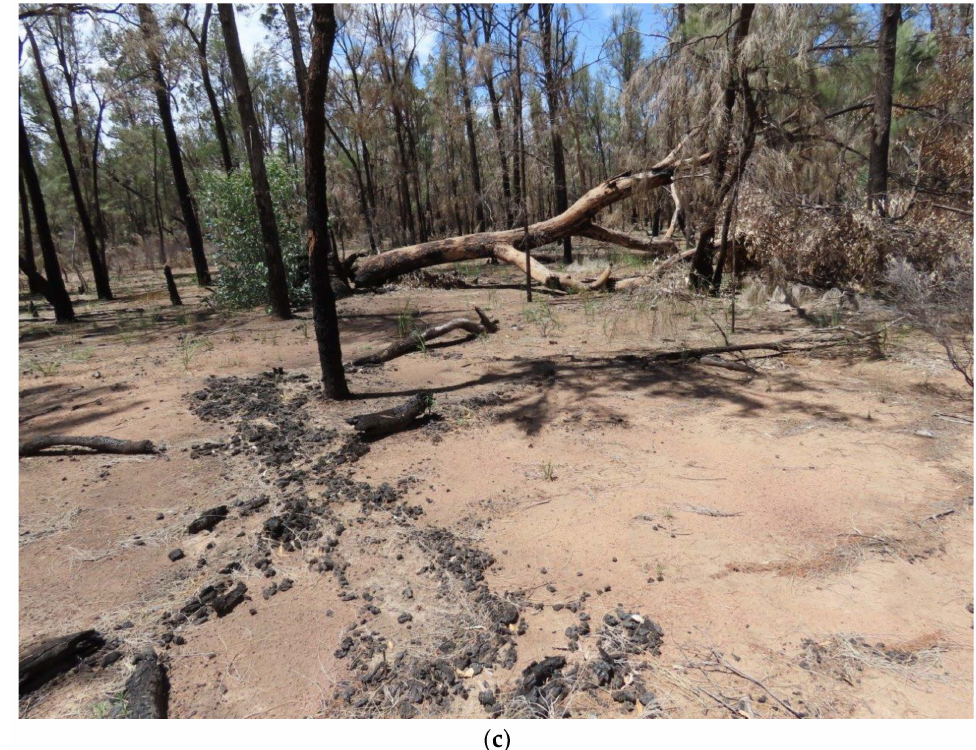
Figure 1. ( a ) Satellite image of the AWC site in central Pilliga with areas affected by the management burn mapped. Pink line indicates the maximum foraging range (3.96 km radius from the mid-point of the burn extent) previously recorded for the species within the study area [22]. The location of roost trees used by N . corbeni and trap locations are also displayed; ( b ) Image showing a typical area of forest burnt by low severity fire; ( c ) Image showing a typical area of forest burnt by higher severity fire. Note the collapsed tree post-fire in the background and burnt-out fallen log in